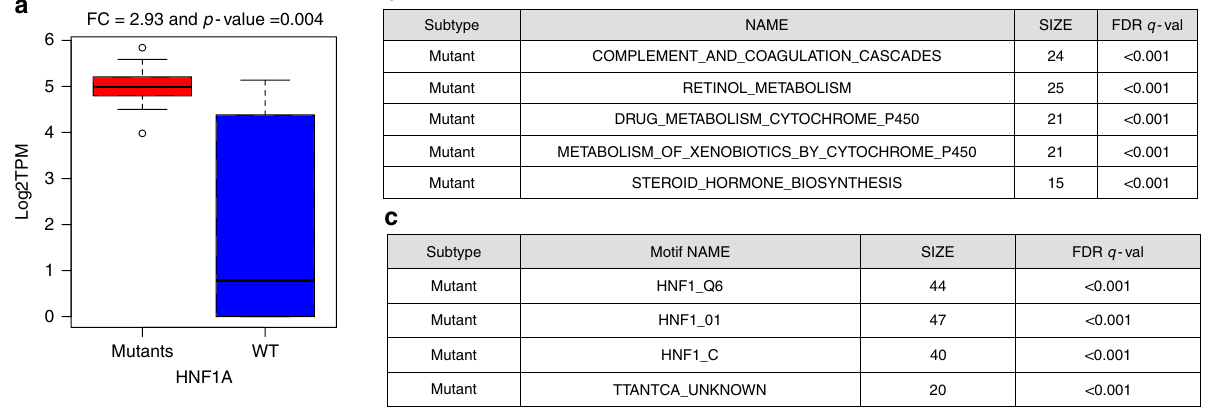
Fig. 6 HNF1A pathway with transcriptionally up-regulation in A-D-M mutant panNETs and alpha cells. a Boxplot of HNF1A gene expression for A-D-M mutant and A-D-M WT PanNETs. HNF1A was homogeneously expressed 2.93 fold higher in A-D-M mutants PanNETs (corrected p -val < 0.004, Benjamini – Hochberg). Center line, median; bounds of box, the 1st and 3rd quartiles; and upper and lower whisker is de fi ned to be 1.5 × IQR more than the third and fi rst quartile. b Table represents signi fi cant KEGG pathways where genes were differentially expressed between A-D-M mutants and A-D-M WT panNETs. c Table represents transcription factor motifs signi fi cantly enriched in promoters of genes differentially expressed in A-D-M mutants and A-D-M WT panNETs. Three HNF1 related motif gene sets from GSEA showed signi fi cant enrichment in genes over-expressed in A-D-M mutant panNETs. GSEA was used to fi nd pathway enrichment from genes differentially expressed between A-D-M mutant and A-D-M WT PanNETs